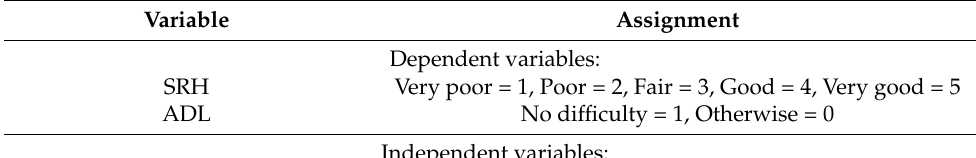
Table 1. The assignment of the variables.